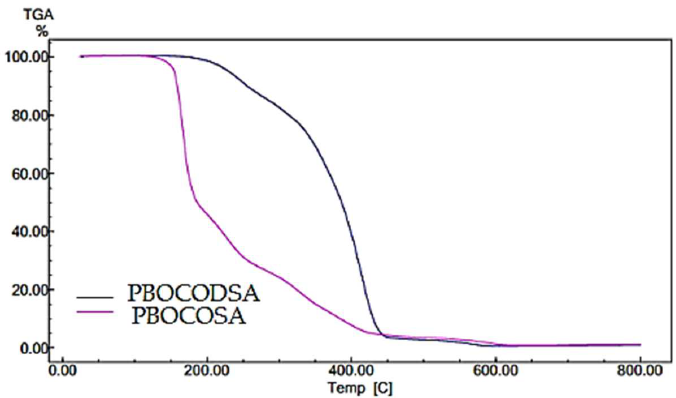
Figure 4. TGA thermograms of PBOCOSA and PBOCODSA.